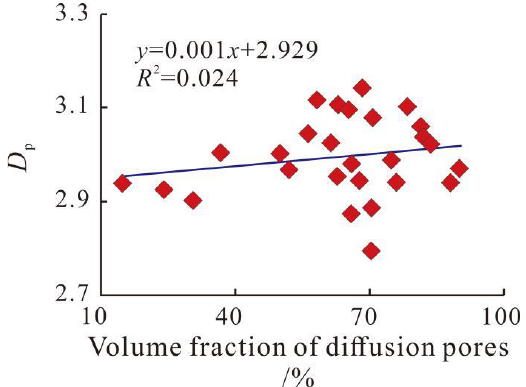
Figure 6. Relationship between volume fraction of diffusion pores and percolation fractal dimension ( D p ).